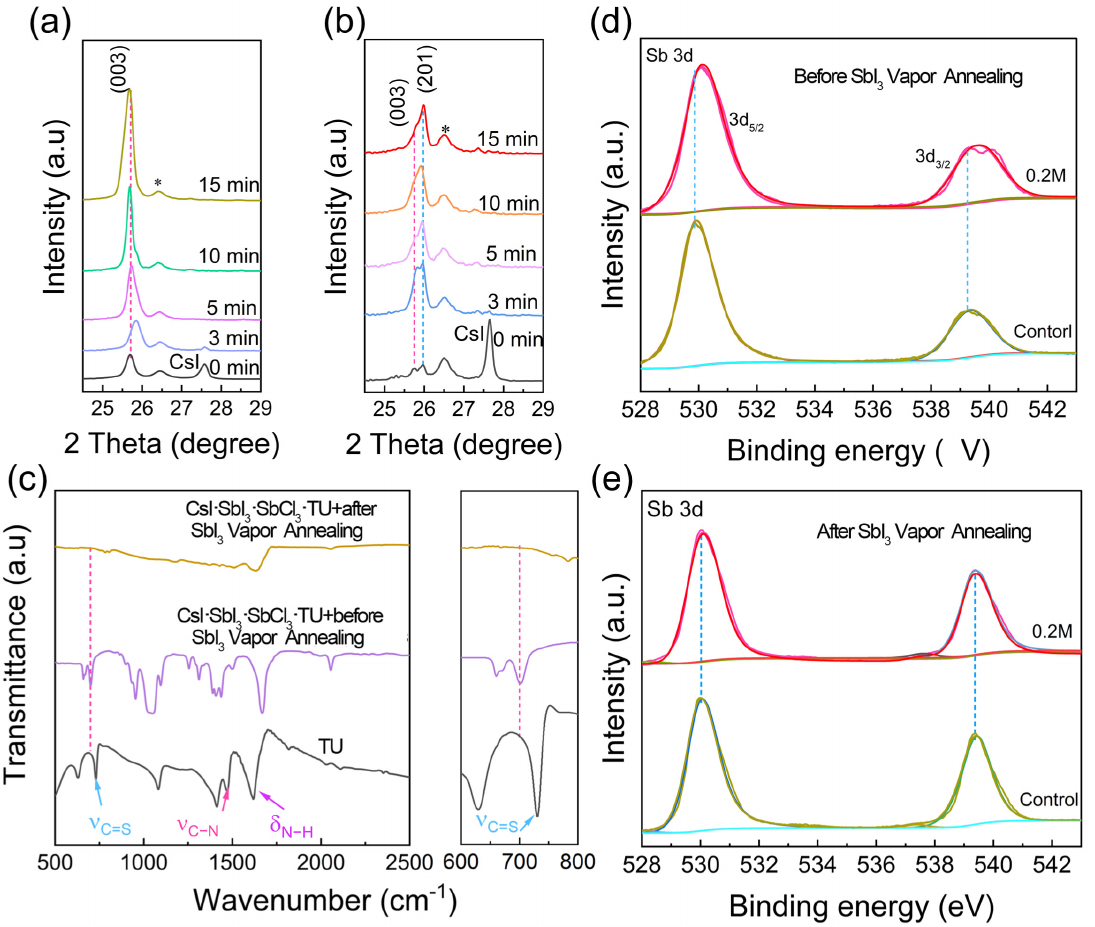
Figure 2. XRD diffraction patterns of ( a ) the control and ( b ) 0.2 M TU additive Cs 3 Sb 2 I 9 − x Cl x films under different SbI 3 vapour annealing time. The annealing time was assigned 0 min, 3 min, 5 min, 10 min, and 15 min, respectively. The XRD peak of “*” symbols belong to the TiO 2 /FTO substrates. ( c ) FTIR spectra of TU, CsI · SbI 3 · SbCl 3 · TU before SbI 3 vapour annealing, and CsI · SbI 3 · SbCl 3 · TU after SbI 3 vapour annealing. ( d , e ) XPS for Sb 3d core level spectra in control and 0.2 M TU